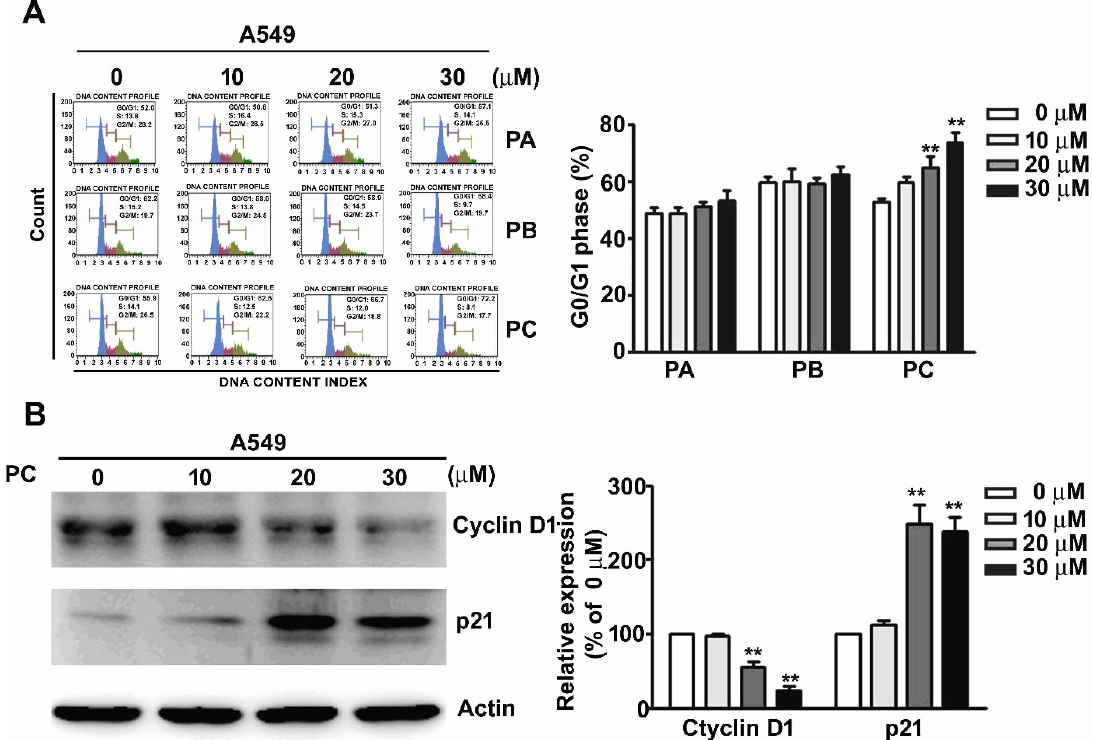
Figure 2. E ff ect of PC on cell cycle arrest in NSCLC cells. ( A ) Cell cycle and apoptosis of human A549 Figure 2. Effect of PC on cell cycle arrest in NSCLC cells. (A) Cell cycle and apoptosis of human A549 lung cancer cells treated with various concentrations (0, 10, 20, and 30 µ M) of PA, PB, and PC were lung cancer cells treated with various concentrations (0, 10, 20, and 30 μ M) of PA, PB, and PC were measured using flow cytometry. ( B ) Cell cycle regulation proteins, cyclin D1 and p21, were further measured using flow cytometry. (B) Cell cycle regulation proteins, cyclin D1 and p21, were further detected to confirm the e ff ect of PC on A549 cells. ** p < 0.01 versus control (line 1), (Mean ± SE, n = detected to confirm the effect of PC on A549 cells. ** p ＜ 0.01 versus control (line 1), (Mean ± SE, n = 3).